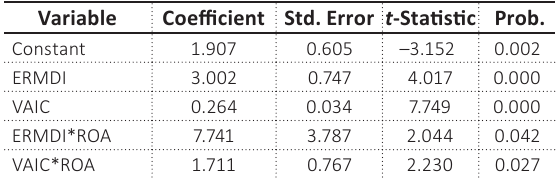
Table 6. Panel data regression analysis with